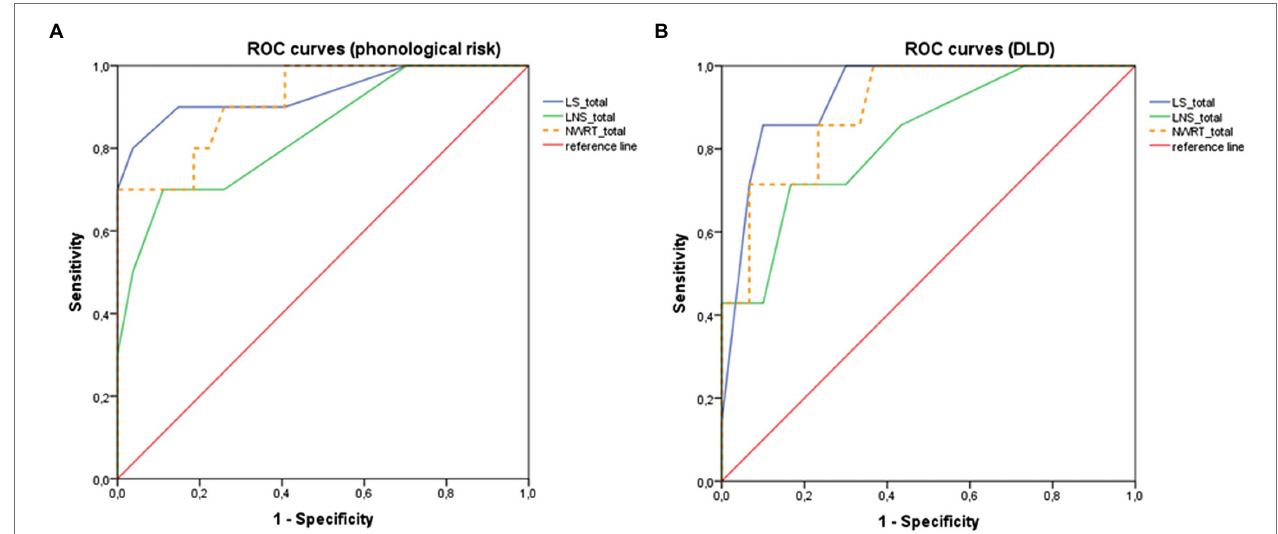
FIGURE 4 | ROC curves for total NWRT, LS, and LNS for the identification of children with (A) phonological risk (distinction between phonological risk, n = 10, and no risk, n = 27)—AUC = 0.917, 0.933 and 0.837, respectively, and (B) DLD (distinction between DLD, n = 7, and non-DLD, n = 30)—AUC = 0.898, 0.931 and 0.826, respectively.